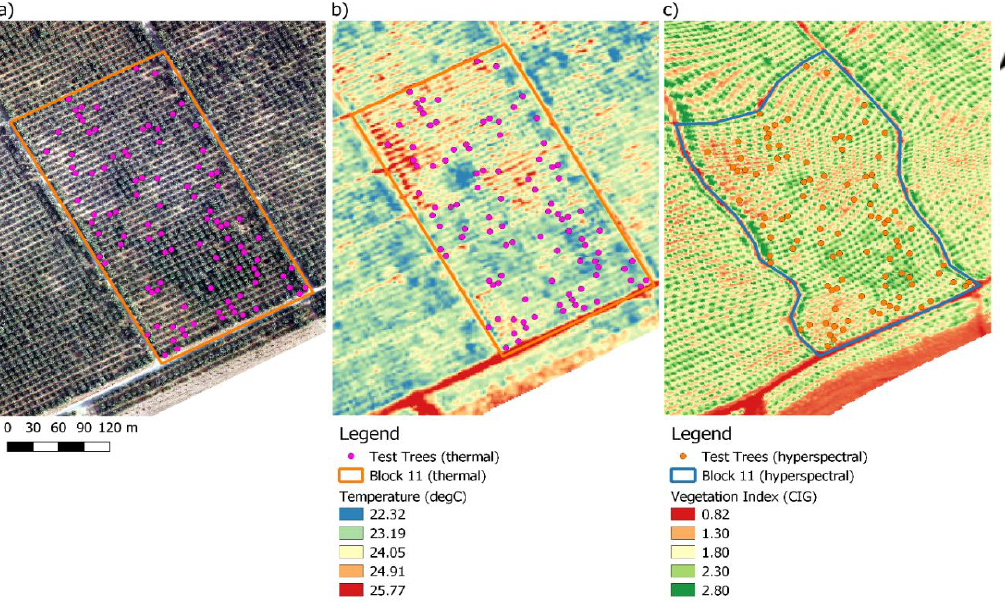
Figure 9. Illustrations of the selected test trees in Block 11 for ( a ) the visual RGB imagery, ( b ) the thermal imagery, and ( c ) the hyperspectral imagery represented as calculated Chlorophyll Index Green (CIG) (Table A1).